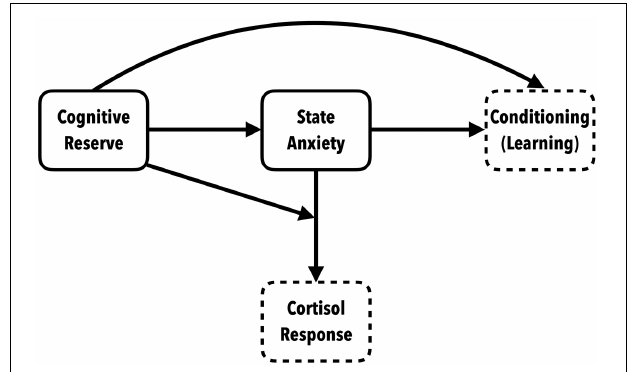
FIGURE 6 | Conceptual model of the role of cognitive reserve in anxiety-triggering situations: indirect relation with conditioning and effect of interaction with SA on the neuroendocrine